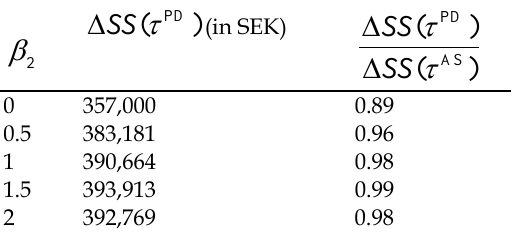
Table 3. Results obtained when solving (14) for the current Stockholm cordon.